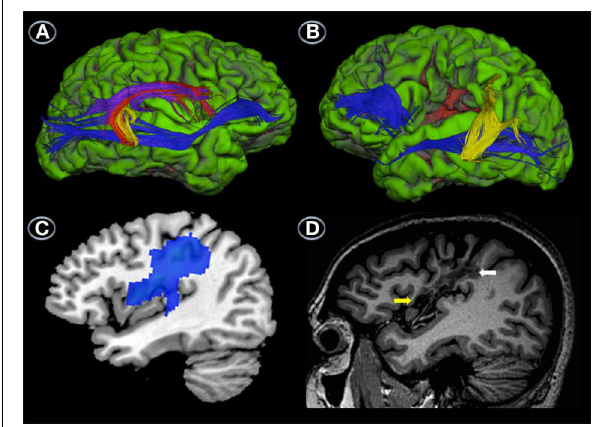
FIGURE 3 | Uninflated surface of the right (A) and left hemispheres (B) (FreeSurfer reconstruction) of the patient with transcortical motor aphasia (RTP) showing gyri cultured in green with sulci shown in red. DTI of right hemisphere perisylvian pathways superimposed on RTP anatomical MRI shows well-developed temporo-frontal, temporo-parietal and parieto-frontal streams (red, yellow, and purple, respectively) and ventral stream (blue) (A) , whereas in the left hemisphere only the parieto-temporal segment of the arcuate fasciculus (yellow) and part of the ventral stream (blue) could be reconstructed (B) . This image also shows the location of the infarct in the lower pericentral region (red area). Parasaggital T 1 -weighted MRI view of the left hemisphere shows the infarction in the sensorimotor cortex (white arrows) and medial insula (yellow arrow) (C) . Parasaggital view of the 18 FDG-PET (MRIcroN) showing an area of reduced metabolic activity in the left fronto-insular region (blue) (D) which is slightly larger than the area of infarction depicted in (C) . See further details in Table 4 .